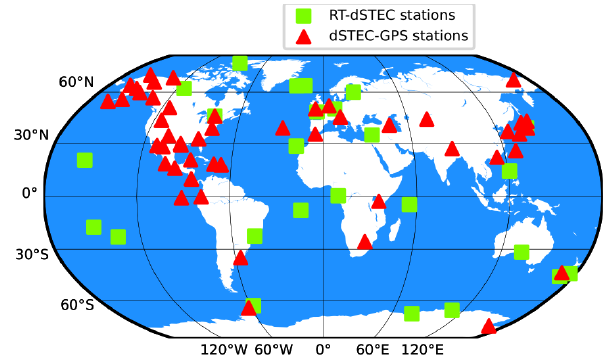
Figure 1. The 25 common real-time stations for RT-dSTEC assess- ment (in green) and 50 external GNSS stations for dSTEC-GPS as- sessment (in